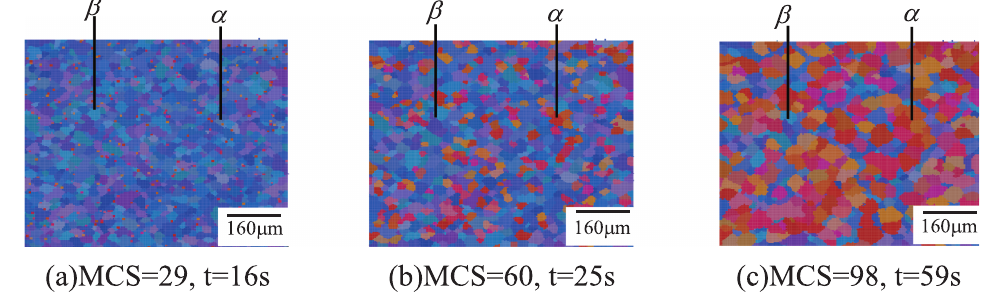
Figure 8: Grain growth of α / β phases in SZ in 1100 rpm and